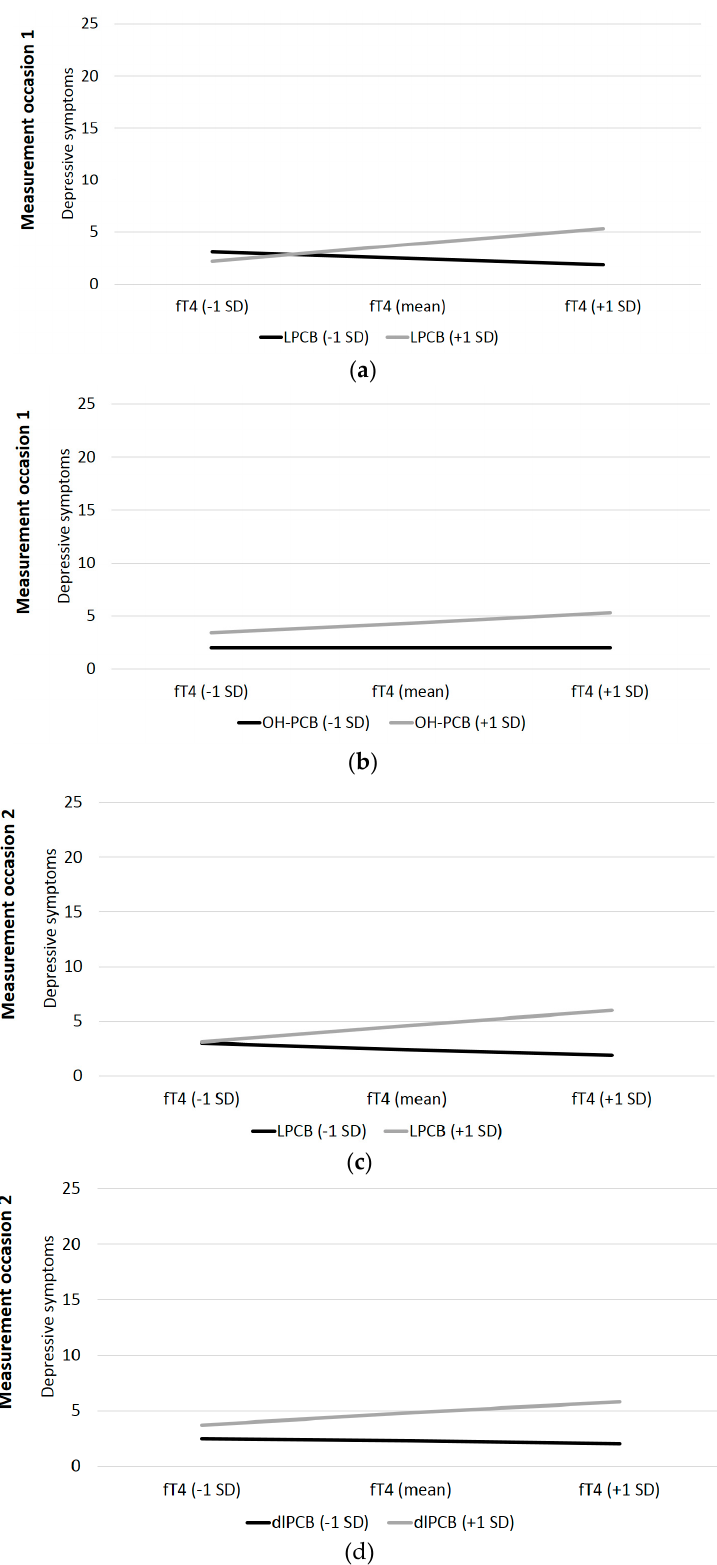
Figure 3. Visualization of the interaction of log transformed and lipid adjusted LPCBs in terms of the association of fT4 with HVA ( a ) and on fT4 with depressive symptoms ( b ).